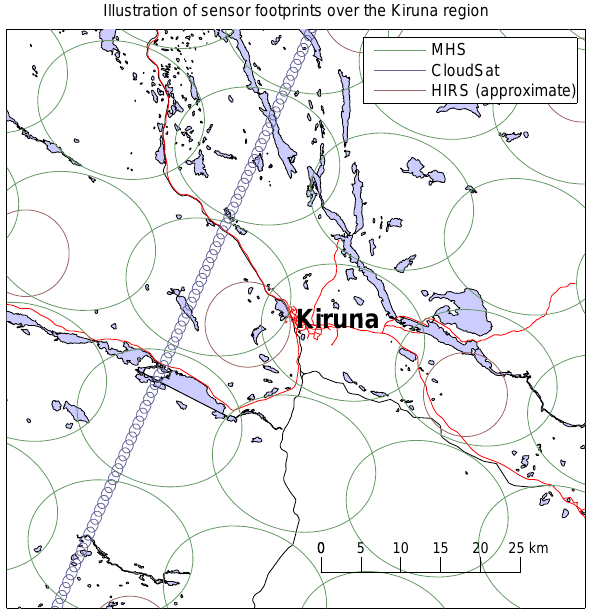
Fig. 1. Footprint of the MHS, HIRS/4 and CPR sensors. The MHS footprint sizes are calculated using an expression by Ben- nartz (2000). The HIRS footprints are approximate. Map data ©OpenStreetMap contributors, CC-BY-SA.